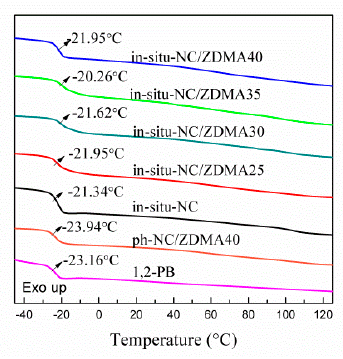
Figure 11. Differential Scanning Calorimetry (DSC) curves of 1,2-PB, in-situ-NC, in-situ-NC/ZDMAs, and